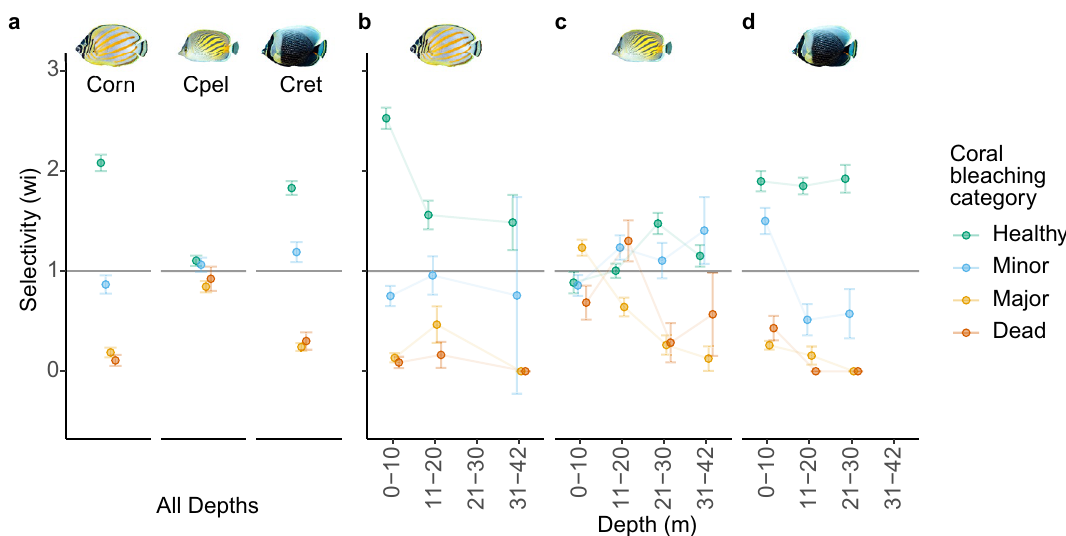
Figure 3. Feeding selectivity and avoidance behaviours in relation to four levels of coral bleaching, for three obligate corallivorous butterflyfishes in Mo’orea, French Polynesia. Feeding preferences across all depths for all three species ( a ) and contrasts of feeding preferences among depths for each species ( b – d ). Corn = Chaetodon ornatissimus (b), Cpel = Chaetodon pelewensis (c) , Cret = Chaetodon reticulatus ( d ). Resource selection measures (metric = ˆ w i ) with confidence intervals spanning values wholly > 1 indicate resource selectivity (i.e., resource use is high relative its environmental availability), values spanning wholly < 1 indicated resource avoidance, and values containing resource avoidance, and values containing 1 indicate resource use is proportional to